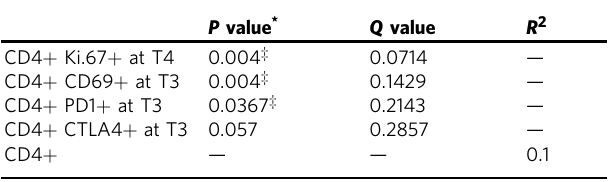
Table 3 Correlation of baseline gut diversity (Inverse Shannon Diversity) with phenotype of tumor-in fi ltrating lymphocytes during chemoradiation treatment.